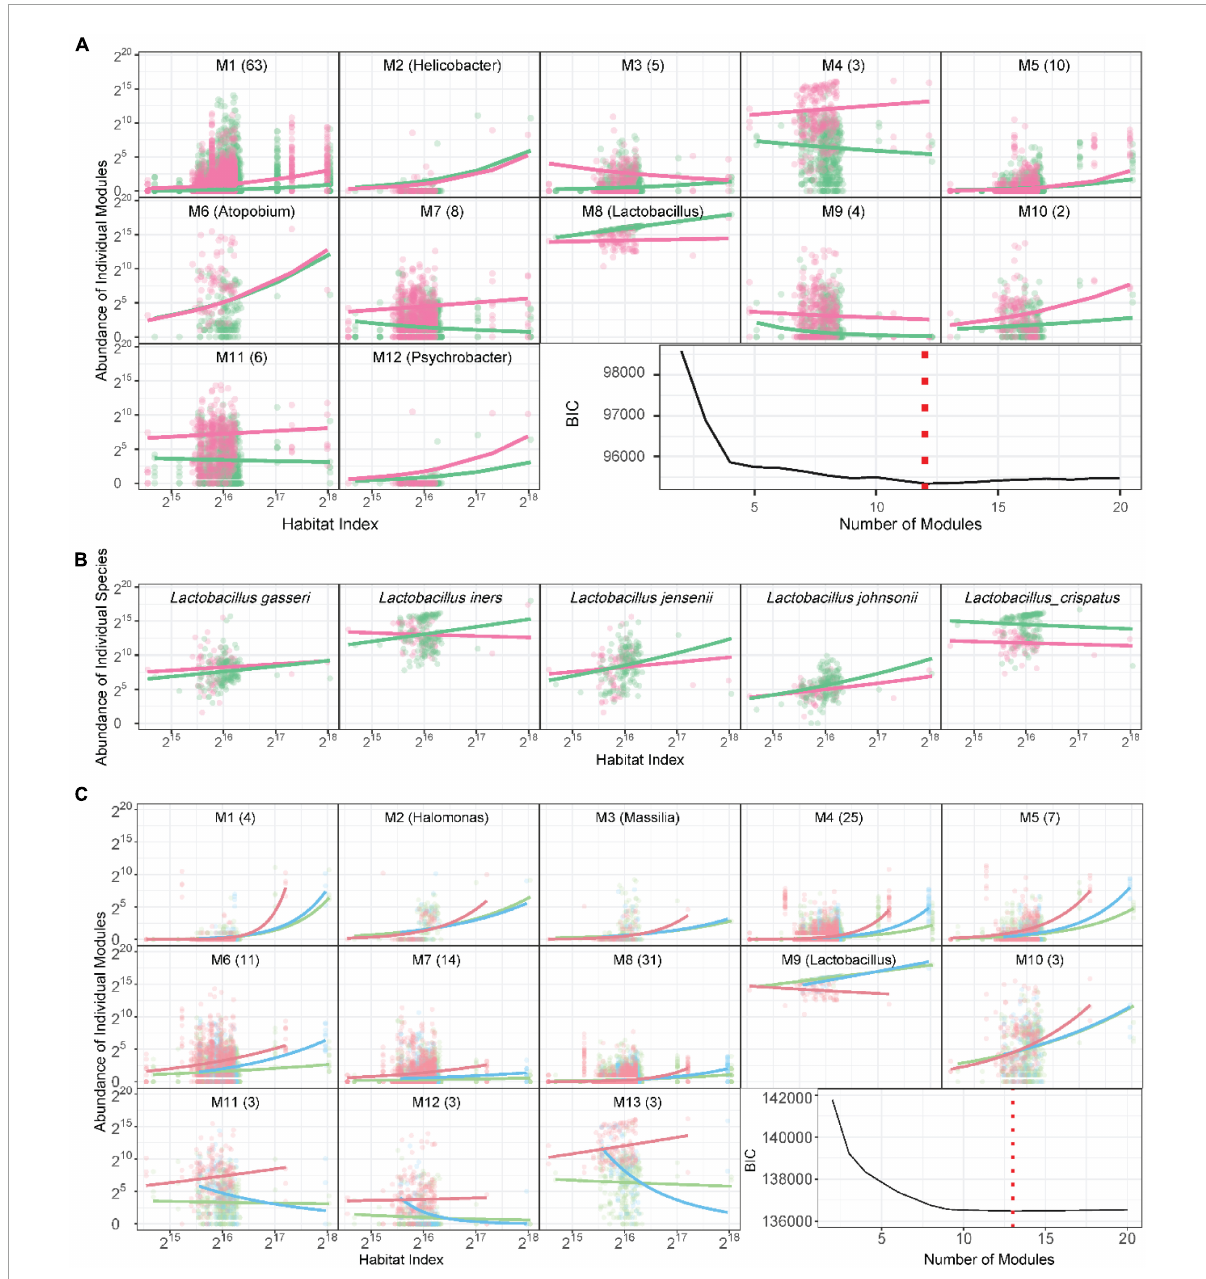
FIGURE3 Functional clustering of genera into distinct modules. (A) BIC analysis identifies 12 functional modules, M1-M12, from 105 genera based on a bivariate functional clustering model incorporating the HI-varying pattern of microbial abundance in healthy (green) and AV groups (red). Shown in the paratheses are numbers of genera contained in a module. (B) Plots of abundance of the five most abundant Lactobacillus species against habitat index. Green and red lines represent the mean curves of HI-varying abundance changes for healthy and AV groups, respectively. (C) BIC analysis identifies 13 functional modules, M1-M13, from 105 genera based on a trivariate functional clustering model incorporating the HI-varying pattern of microbial abundance in the healthy category (pH = 3.8, green), the sub-healthy category (pH = 4.0–4.4, blue), and the AV category (pH = 4.6–5.4, red). Shown in the paratheses are numbers of genera contained in a module. Blue, green, and red lines represent the mean curves of HI-varying abundance changes for the three categories, respectively.